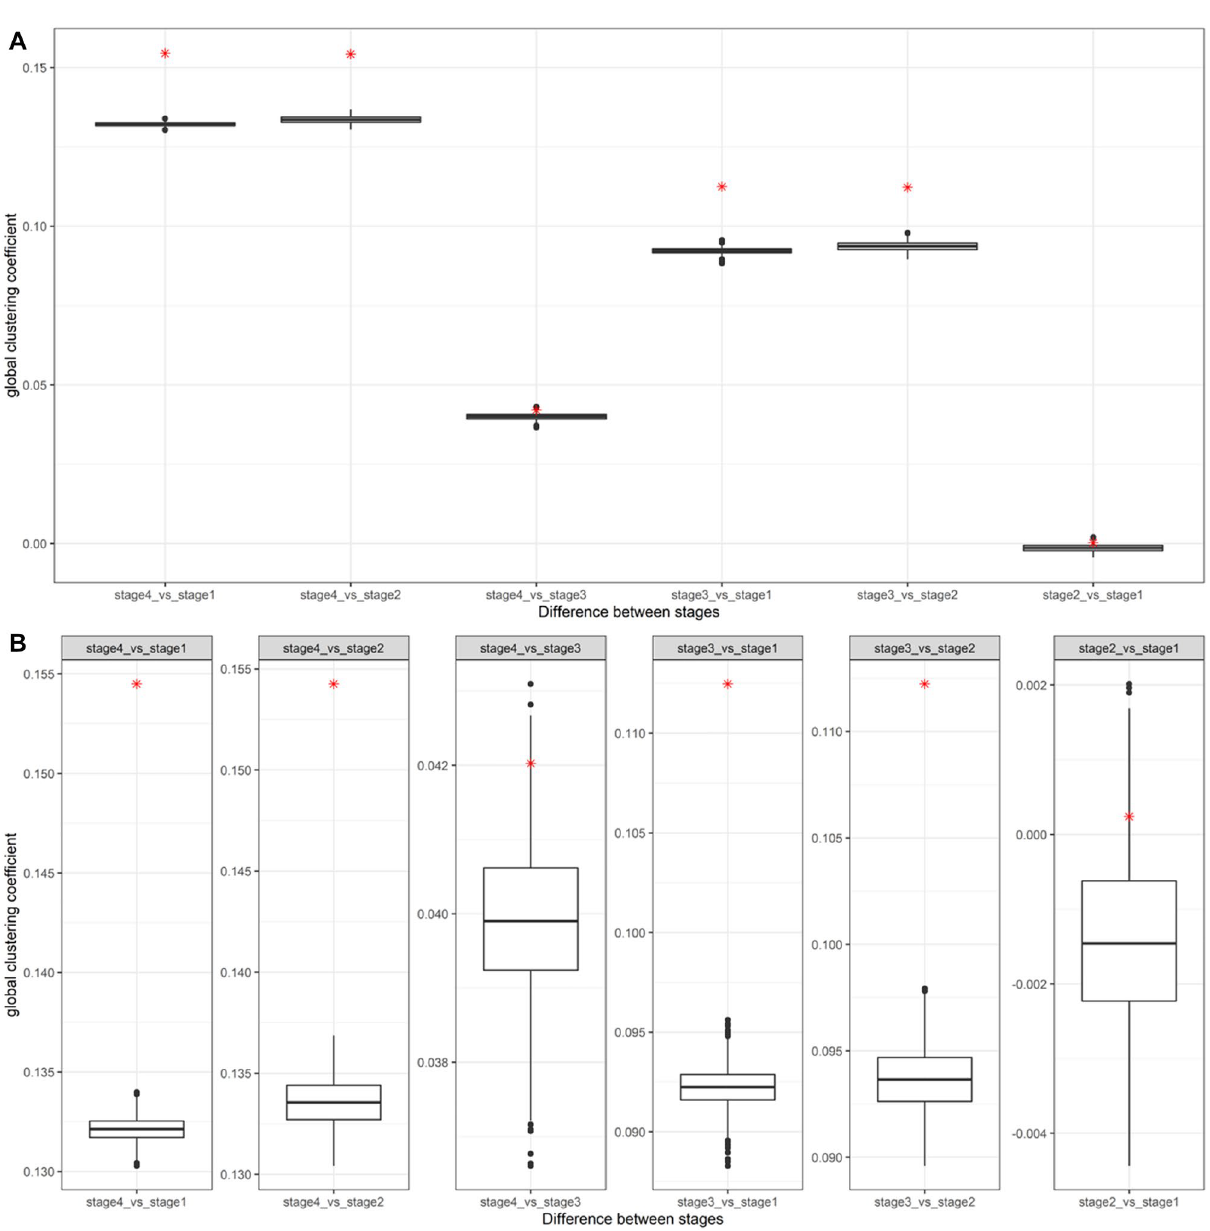
Figure 2. The distributions of differences in global clustering coefficients between stages and observed values of